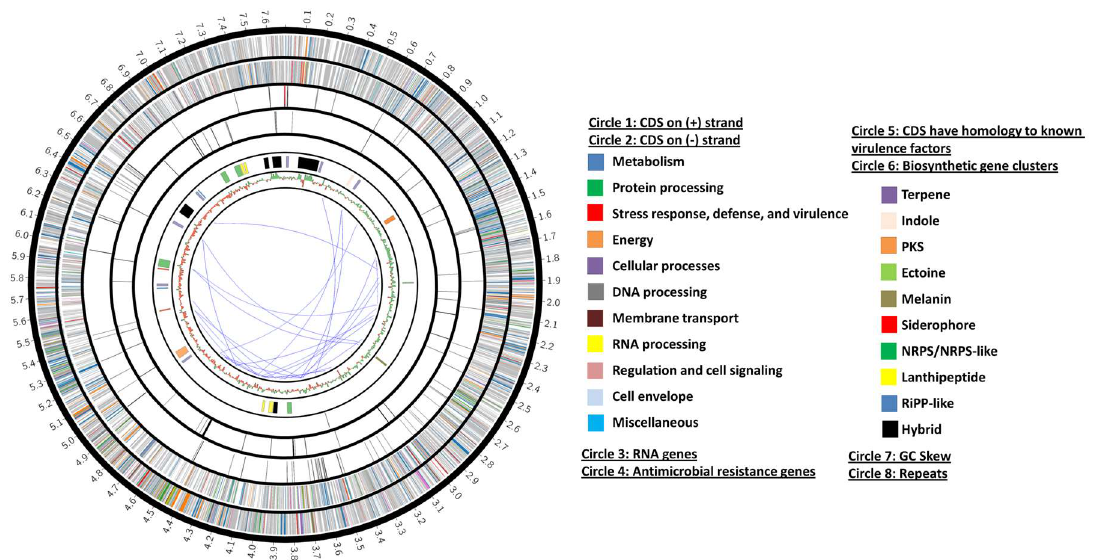
Figure 1. ( a ) The colony morphology of the strain AC-40 on starch casein agar; ( b ) zone of inhibition in (mm) produced by the cell-free supernatant and ethyl acetate extract of the strain AC-40 against B.C ( Bacillus cereus ), S.A ( Staphylococcus aureus ), MRSA (methicillin-resistant Staphylococcus aureus ), E.C ( Escherichia coli ), P.A ( Pseudomonas aeruginosa ), and CA ( Candida albicans ). An amount of 10% DMSO was used as a negative control, and gentamycin (10 µg/mL) was used as a positive control .